Question: Identify the chart type used in this figure.
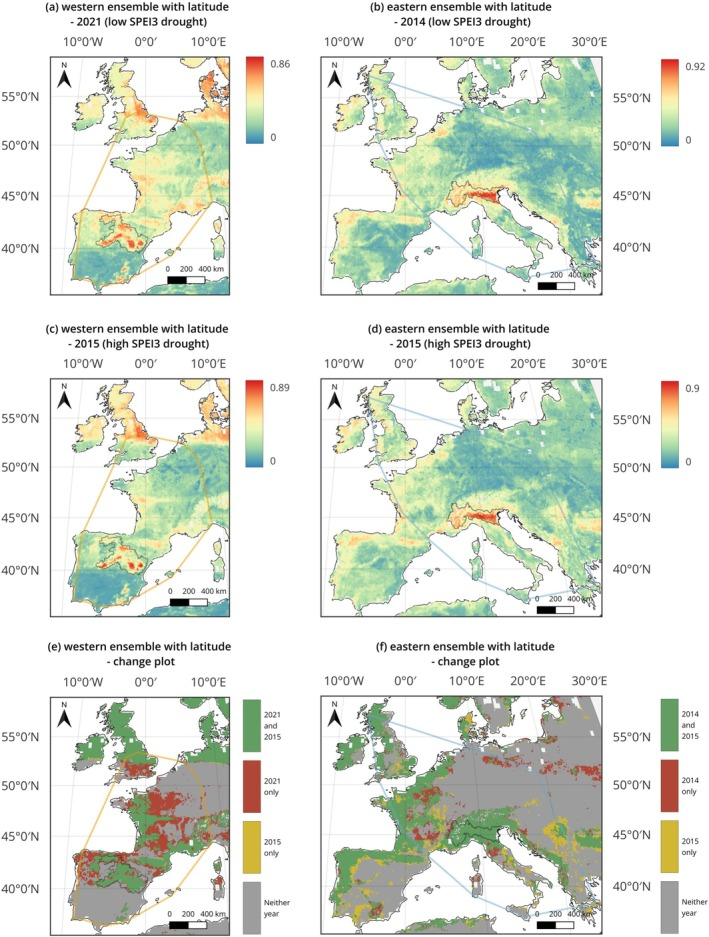
Answer: heatmap